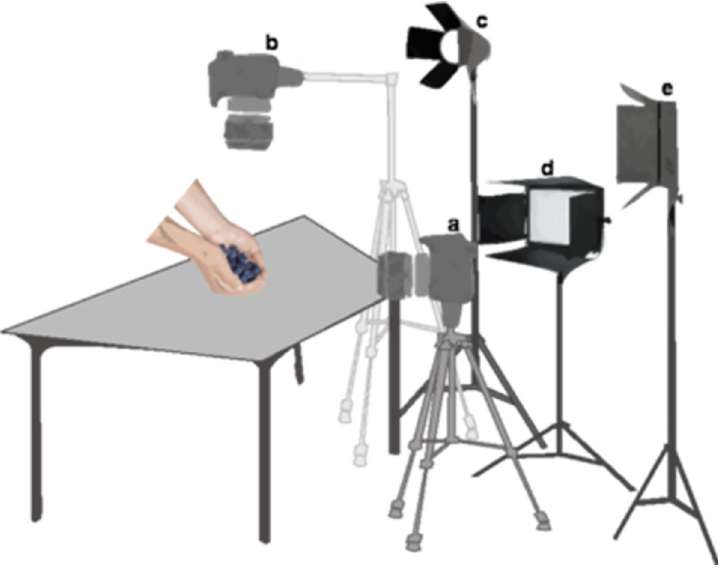
Fig 2. Spatial arrangement of the equipment used to acquire the images. (a) frontal-view camera, (b) top-view camera, (c) halogen spotlight (a similar spotlight was positioned on the left side of the frontal-view camera but is not here represented), (d and e) LED spotlights (a spotlight similar to d was positioned on the left side of the frontal-view camera but is not here